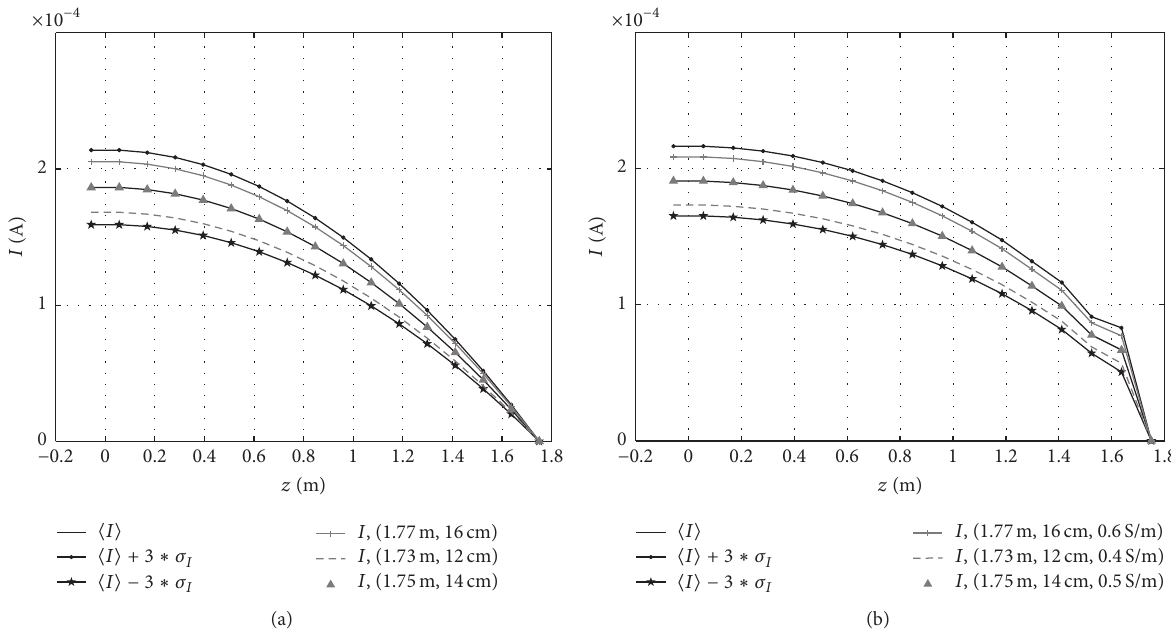
Figure 5: Induced axial current in the human body: ⟨𝐼⟩ is stochastic expected value, 𝜎 𝐼 is standard deviation, and 𝐼 is the value obtained from (a) analytical deterministic model, two input RVs: length and radius (𝐿,𝑎) , and (b) numerical deterministic model, three input RVs: length, radius, and conductivity (𝐿,𝑎, 𝜎) .